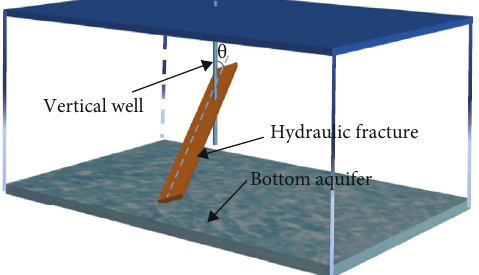
Figure 1: Schematic diagram of the physical model used in this